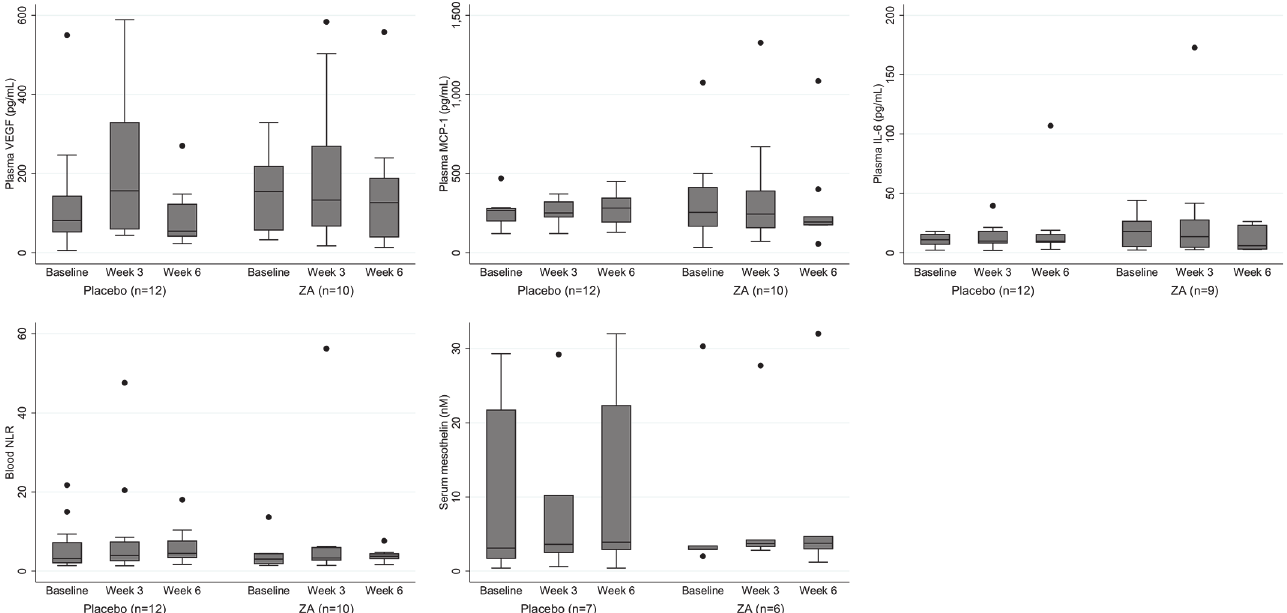
Fig 5. Box and whisper plot showing the change in blood biomarkers over time for the 2 treatment arms. The horizontal line with the box represents the median. The box edges represent the lower (25 th ) and upper (75 th ) quartiles. The whiskers represent the lower and upper adjacent values. Outside values are plotted